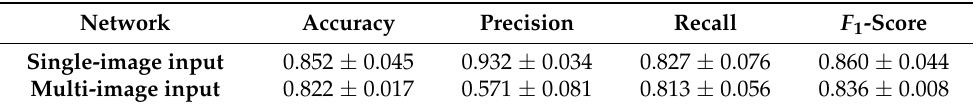
more accurate than the multi-image input model.